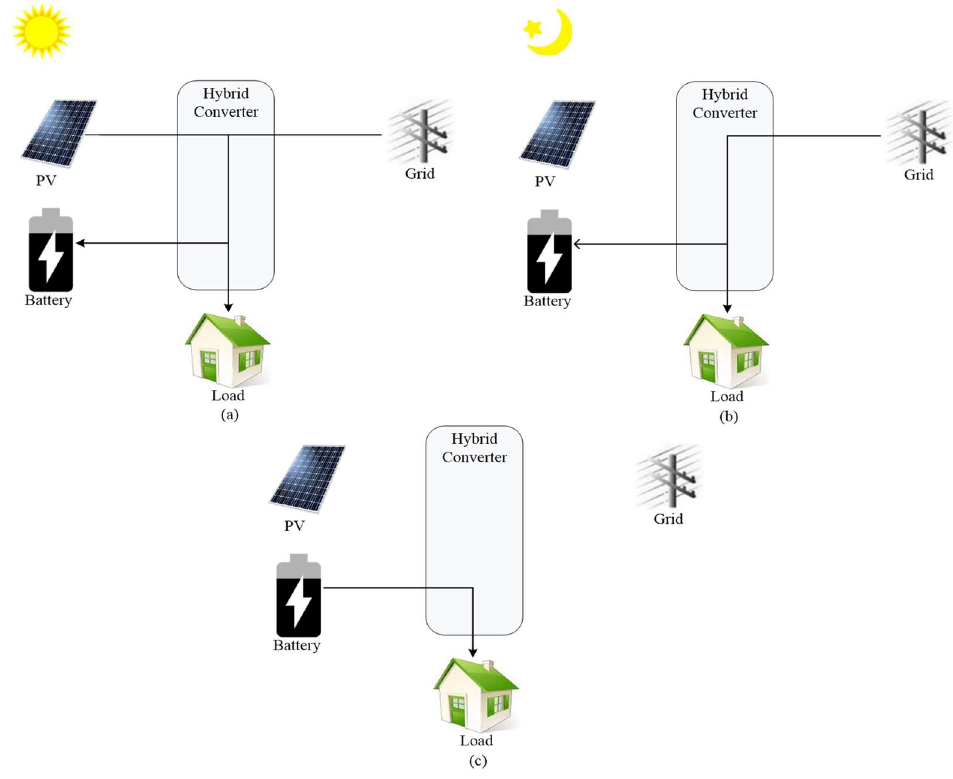
Figure 3. On-grid with battery backup mode: PV power is sufficient ( a ), PV power is insufficient ( b ), when a grid fault occurs ( c ). when a grid fault occurs ( c ).